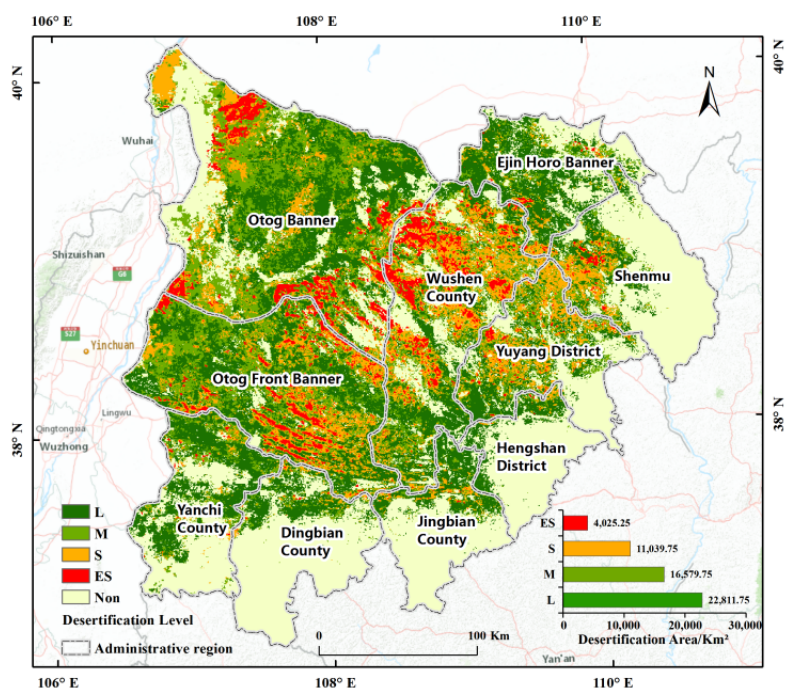
Figure 6. The spatial distribution of different levels of desertification in Mu Us Sandy Land in 2018.